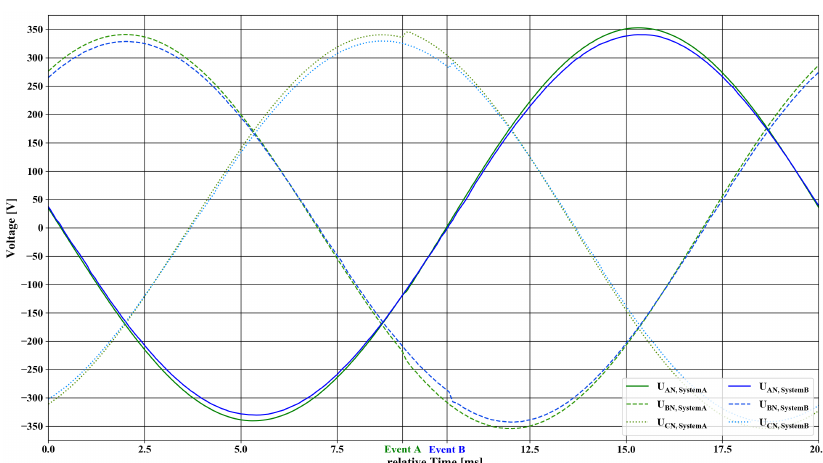
Figure 8. Comparison of the different transient systems response to the step of the voltage. The voltage of both three-phase systems are overlayed and synchronised. The occurrence of every step event is indicated for each setup separately. Neither system shows a significant amount of disturbance.